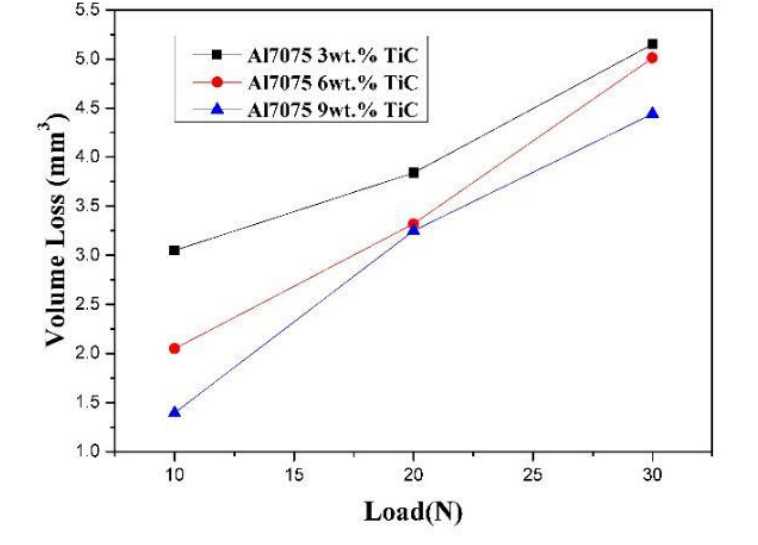
Fig. 11. Variation of wear rate with load at a sliding velocity of 3.14 m/s.